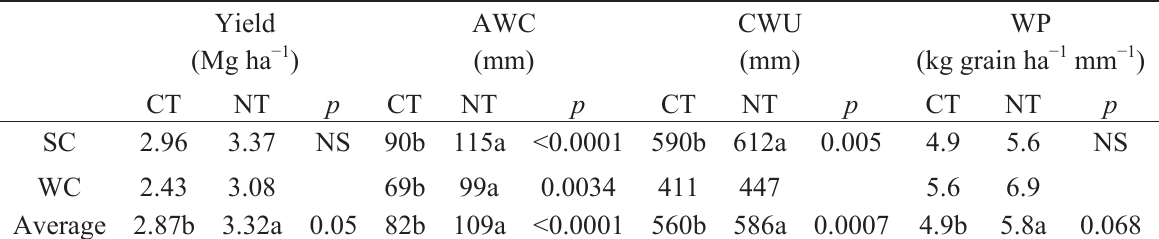
Table 2. Crop yield, soil available water content (AWC) at seeding, consumptive water use (CWU), and water productivity (WP) in no till (NT) and conventional till (CT) for summer crops (SC) and winter crops